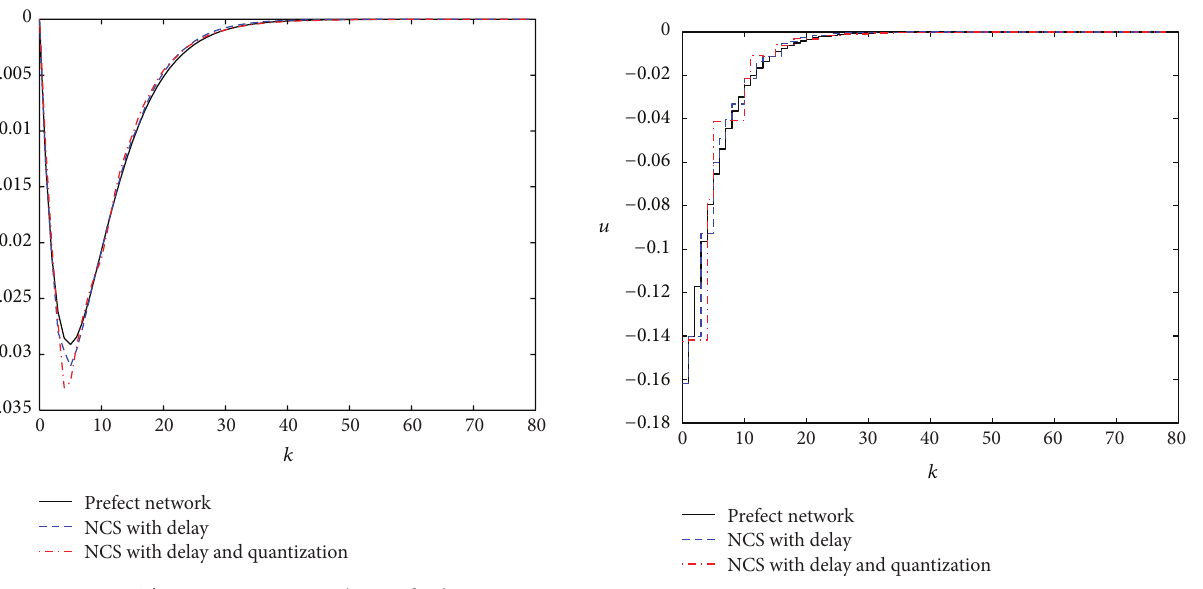
Figure 15: The control input (Example